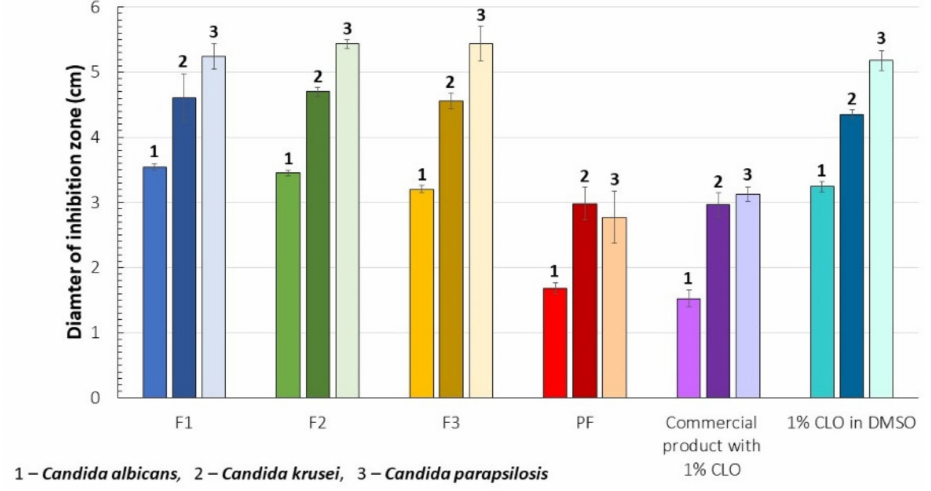
Figure 6. Antifungal activity of the films against Candida albicans , C. krusei , and C. parapsilosis . Diameters of the inhibitions zones observed for F1–F3 and the placebo films (PF) were presented with reference to the commercially available product with 1% CLO and 1% CLO dissolved in DMSO ( p <